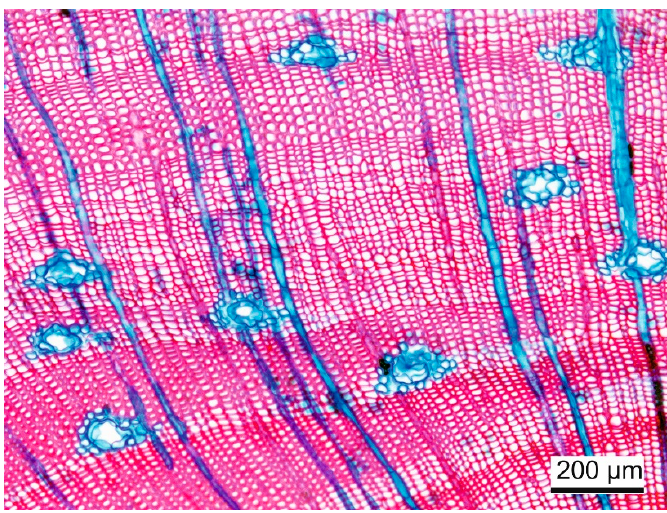
Figure 5. Branch wood of Pinus nigra stained with astablue/safranin.